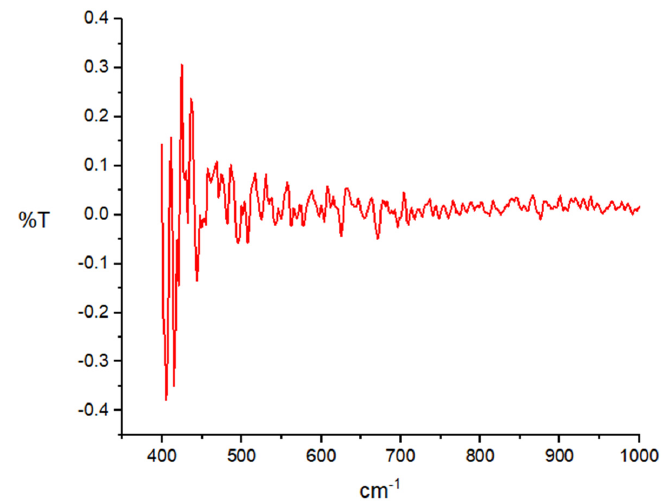
Figure 3. FTIR spectrum analysis of AgNPs.